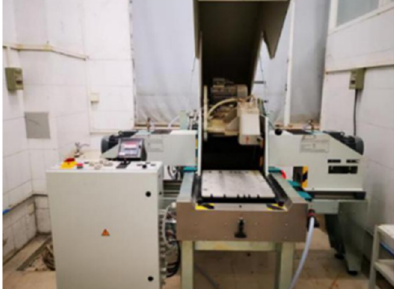
Figure 1. Cutting machine.